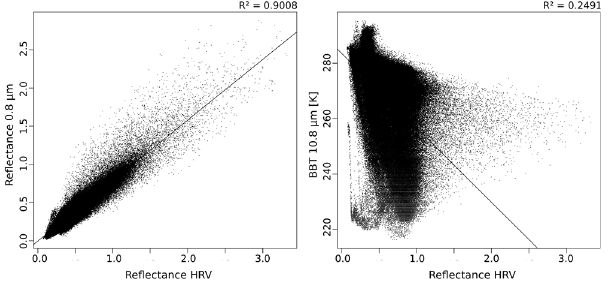
Fig. 2. Relationship between the HRV reflectance and the re- flectance at 0.8µm (left), and the BBT at 10.8µm (right) for each pixel of a section of the SEVIRI scene of 17 January 2011 showing Europe.